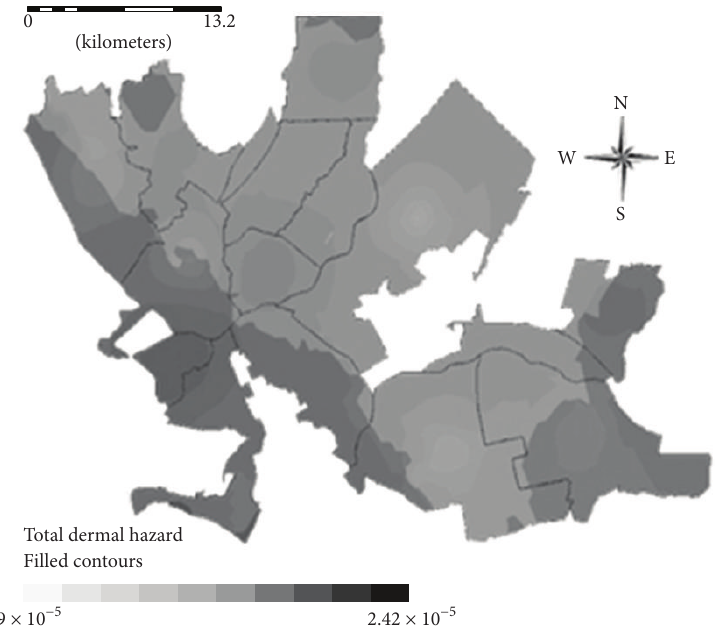
F 7: TTHM hazard index via dermal